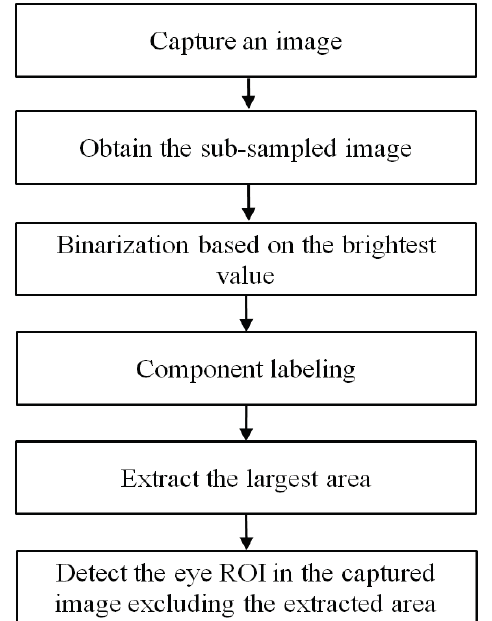
Figure 5. Flowchart to remove the area caused by external light behind user.